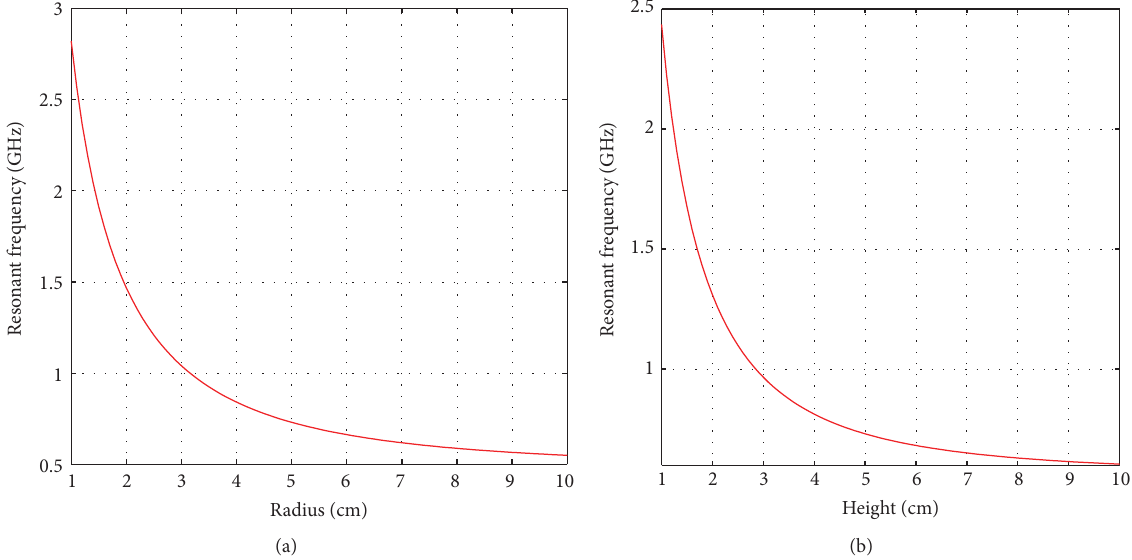
Figure 3: Resonant frequency as a function of the radius (a) and height (b) of a cylindrical DRA with relative permittivity 𝜖 𝑟 = 10 .